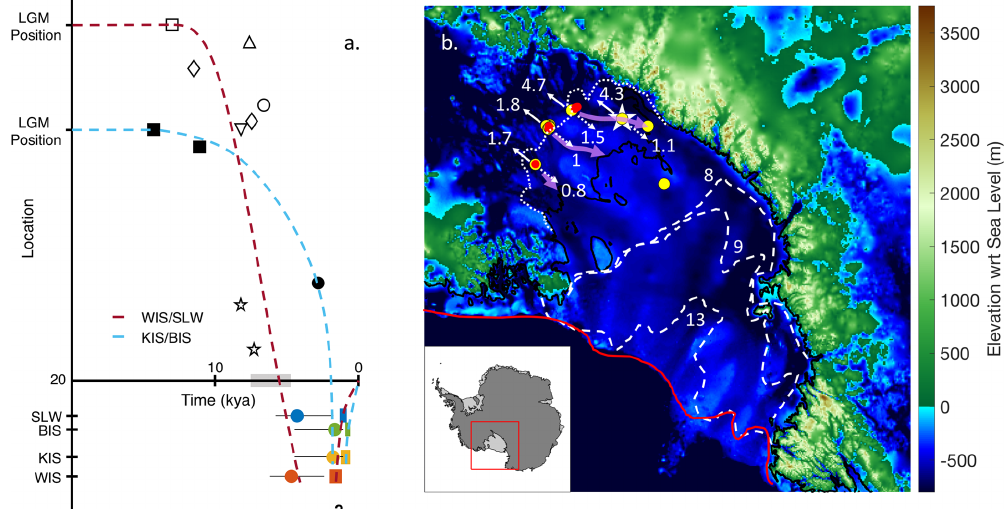
Figure 9. The evolution of grounding line positions in the Ross Embayment for the past 20000 years. (a) Schematic for grounding line position along the flow lines of the Whillans Ice Stream (maroon dashed line) as well as the Bindschadler Ice Stream and Kamb Ice Stream (blue dashed line). The colored dots represent the optimal grounding line retreat timing (error indicated by thin black lines) seen in Fig. 8. The colored bars represent the optimal timing of grounding line readvance (between the 32nd and 68th percentiles). Symbols represent age constraints on grounding line position from the following studies: Baroni and Hall (2004) (right-side-up empty triangle), Bart et al. (2018) (solid square), Conway et al. (1999) (solid circle), Cunningham et al. (1999) (empty square), Jones et al. (2015) (empty circle), Licht et al. (1996) (empty diamond), McKay et al. (2016) (upside-down empty triangle), Spector et al. (2017) (empty star). Open symbols represent ages along/near the flow line of the Whillans Ice Stream, and solid symbols represent ages along the flow line of the Bindschadler Ice Stream. The gray bar along the grounding line represents grounding line retreat at WGZ calculated in Venturelli et al. (2020). (b) Map view of Holocene grounding line positions in the Ross Embayment. The background image is bed elevation (Fretwell et al., 2013). Yellow dots denote the location of sediment cores taken for radiocarbon and TOC analysis. Red dots denote the location of deep temperature profiles examined in this study. The cyan diamond indicates the location where sediment porewater was collected and analyzed. Red line indicates LGM grounding line position (Bentley et al., 2014). Dashed white lines indicate grounding line retreat from Lee et al. (2017). The corresponding numbers indicate timing in kiloyears (thousands of years). The dotted white line shows the most retreated grounding line position modeled in Kingslake et al. (2018). Solid white arrows indicate timing of grounding line retreat in kiloyears, and dotted white arrows indicate timing of grounding line readvance over those sites. Thick purple arrows indicate flow lines along the Whillans, Kamb, and Bindschadler ice